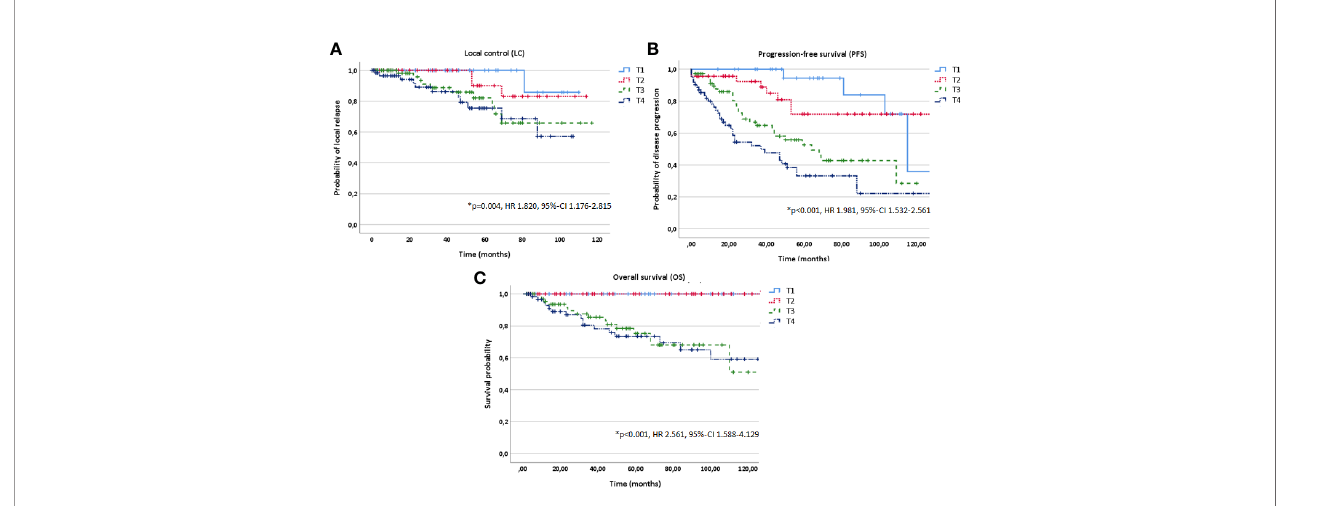
FIGURE 3 | Kaplan-Meier estimates for local control (A) , progression-free survival (B) and overall survival (C) in dependence of T stage